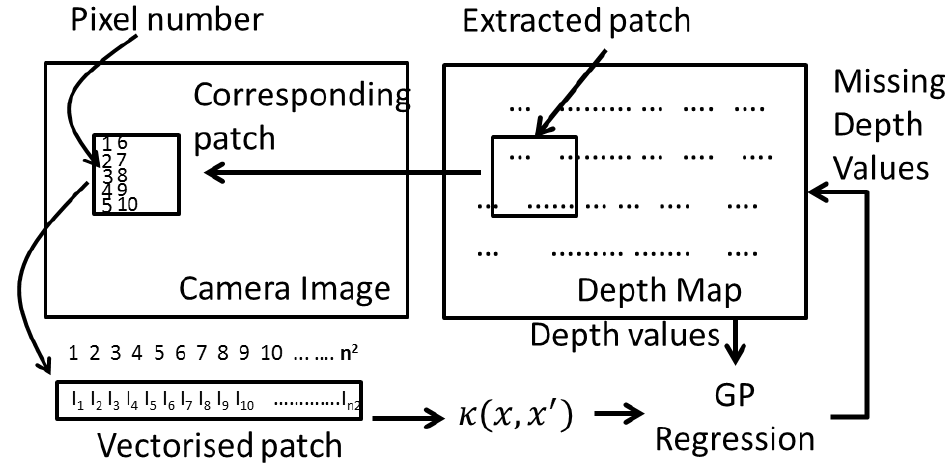
Figure 4. The sequence of steps in Gaussian Process (GP)-based resolution matching algorithm.